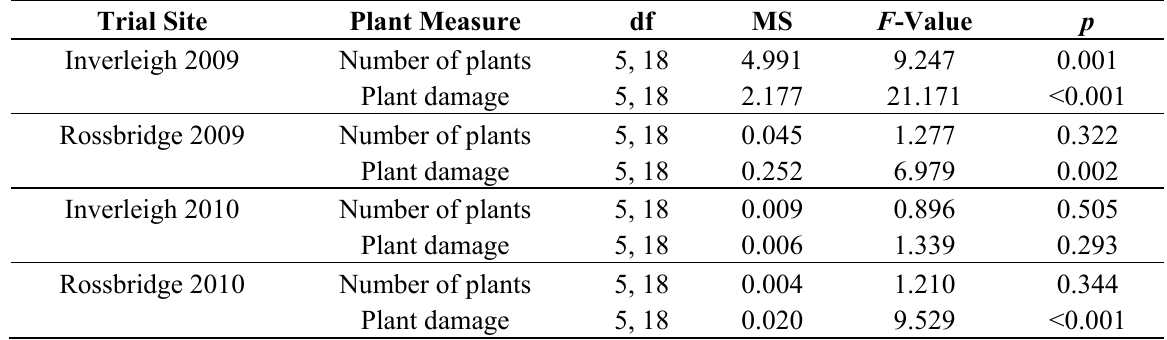
Table 4. Repeated measures ANOVAs comparing the overall treatment effects for number of plants and plant damage scores across each field